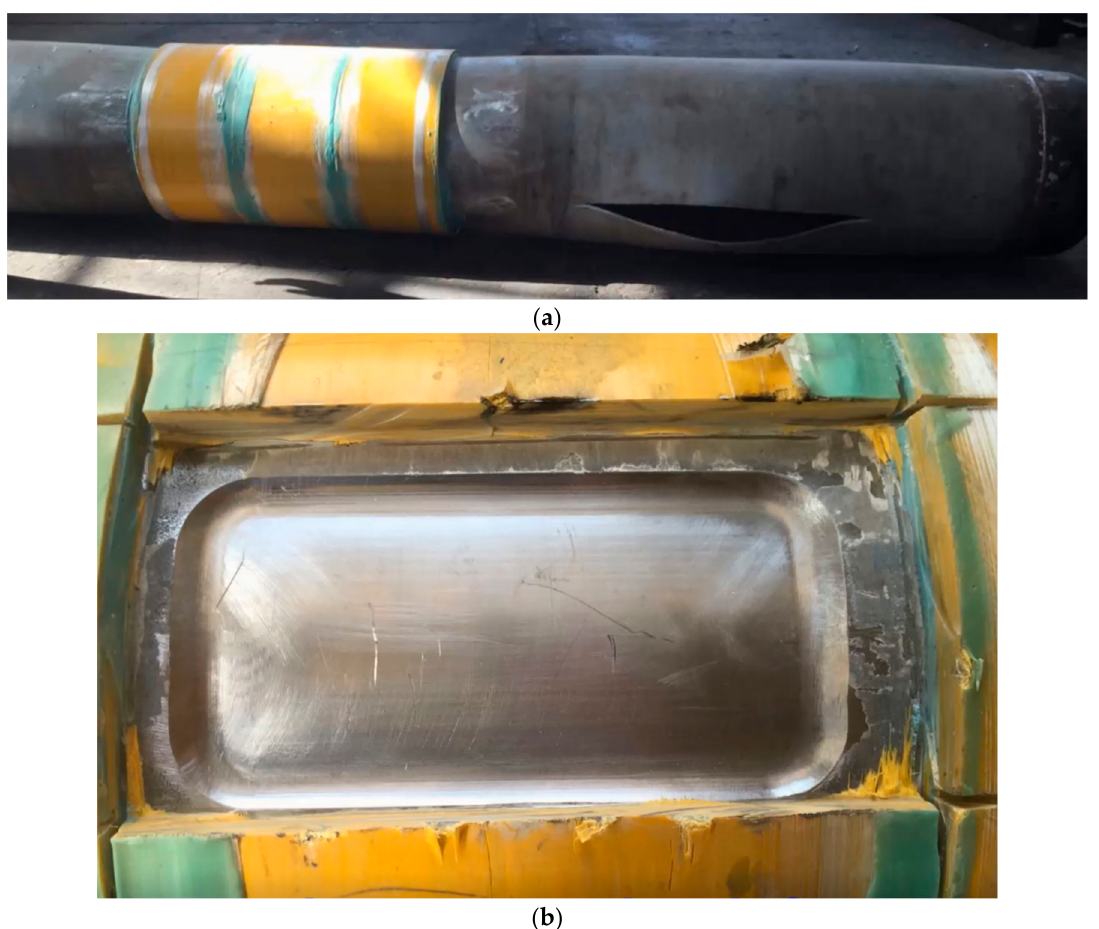
Figure 9. Pipe after the burst test: ( a ) highlight of the fracture direction; ( b ) highlight of the defect after the test.